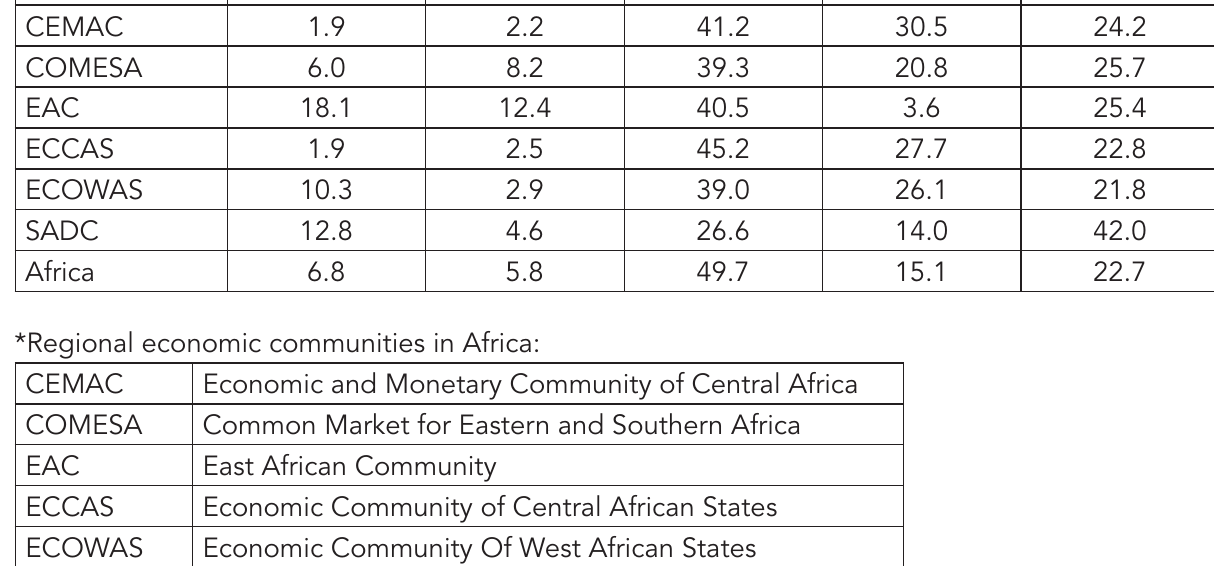
Table 4: Low trade shares between regional economic communities in Africa* (percentages) (Atta-Mensah, 2008) Intra-REC Rest of Africa EU US